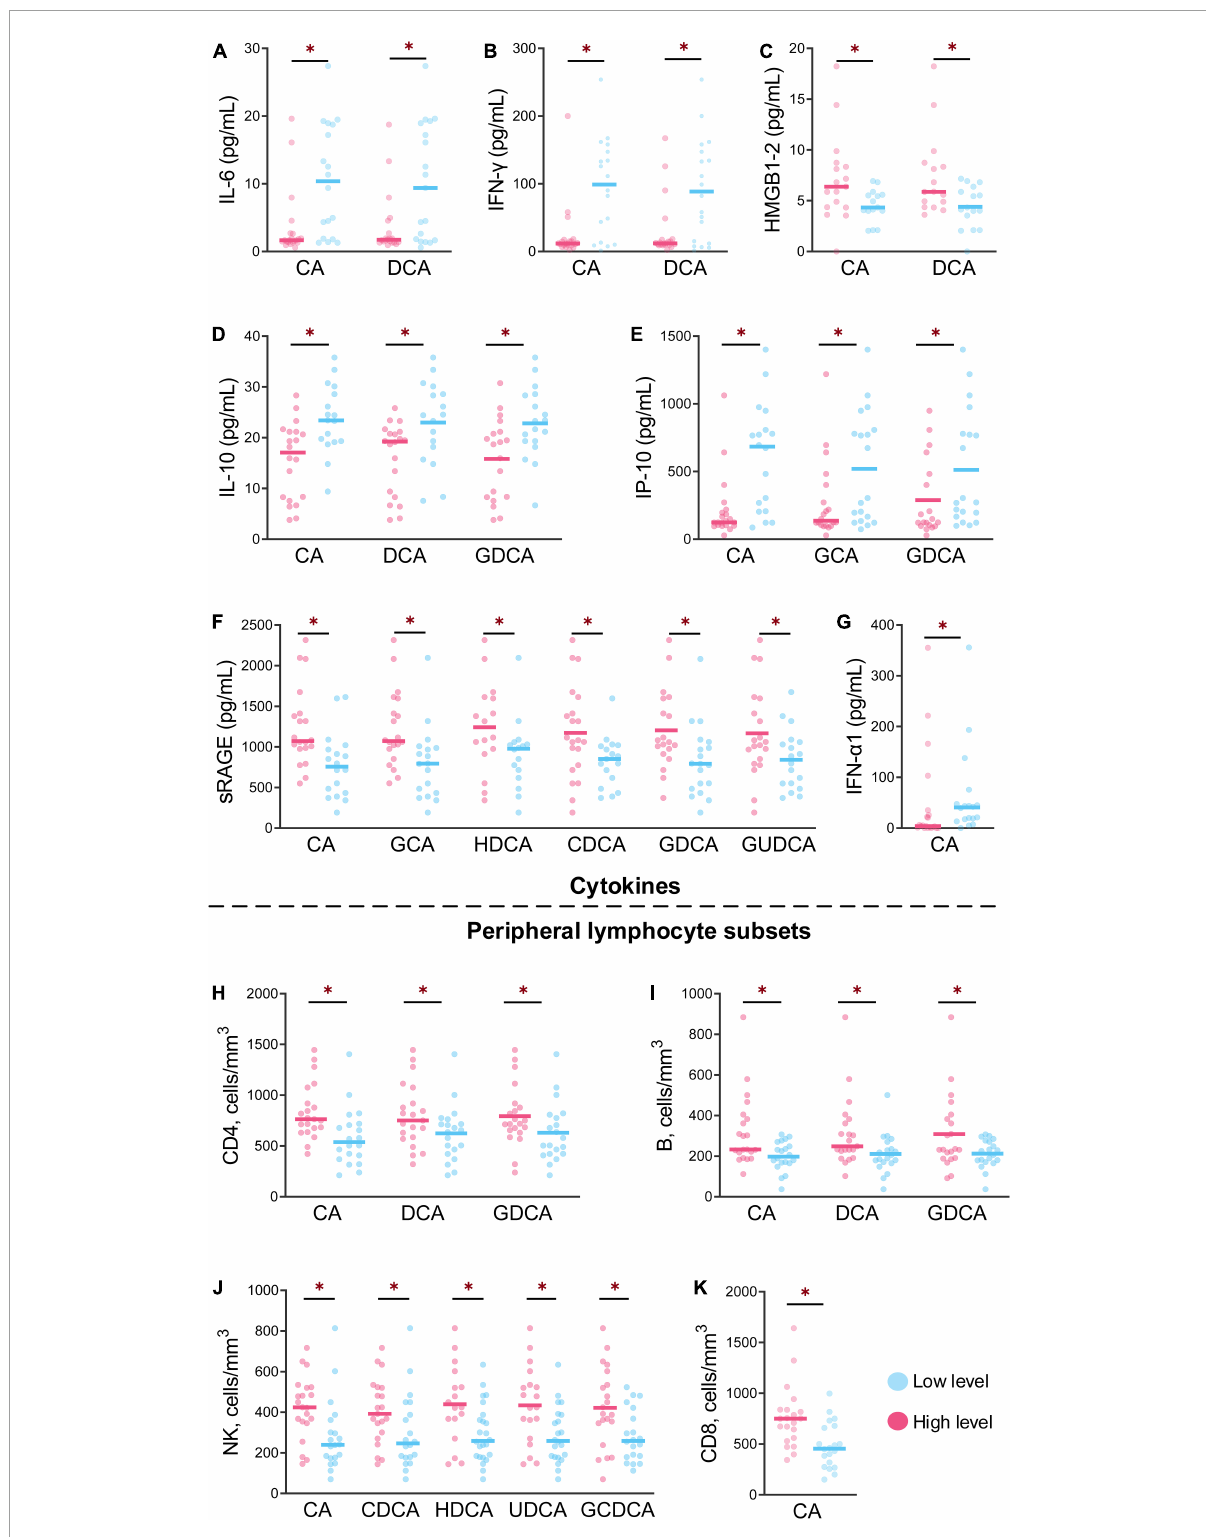
FIGURE4 The levels of cytokines and peripheral lymphocyte subsets at the different levels of bile acids were significantly different between the patients and asymptomatic cases. (A–G) Show the levels of seven cytokines between the high and low of bile acid levels with significant differences. (H–K) Show the contents of four peripheral lymphocyte subsets between high and low bile acid levels with significant difference ∗ p <